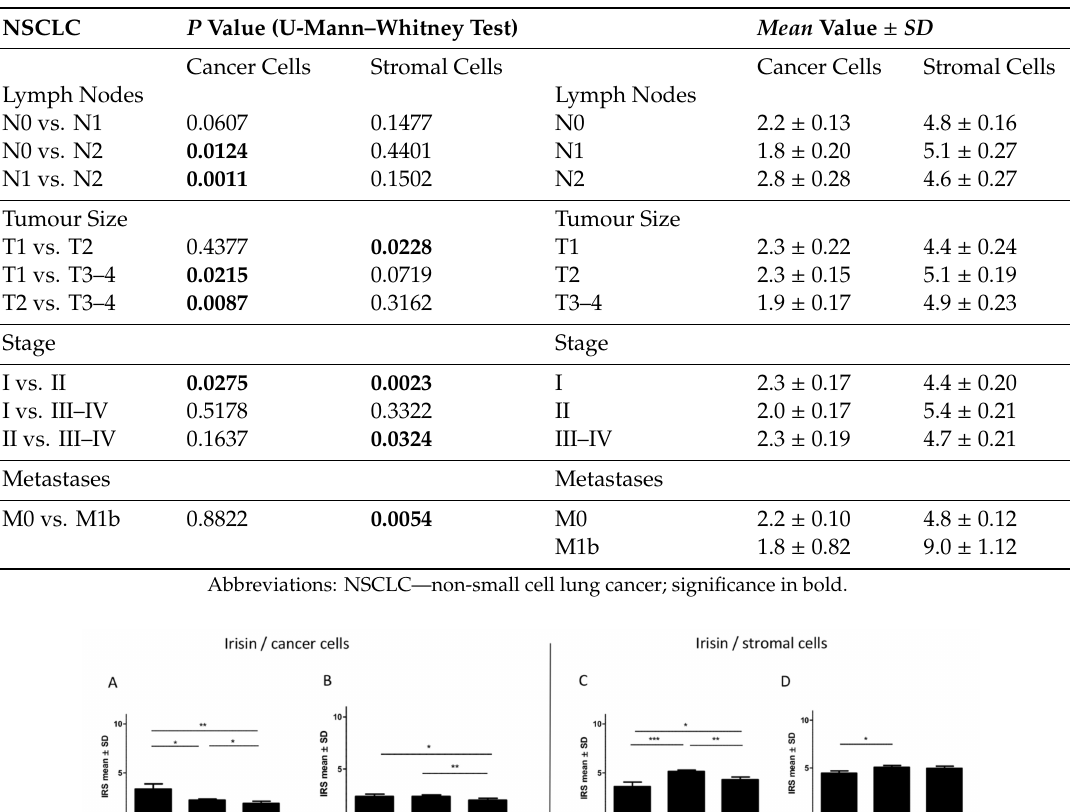
Table 2. Associations of irisin expression level with clinicopathological characteristics in patients with NSCLC.